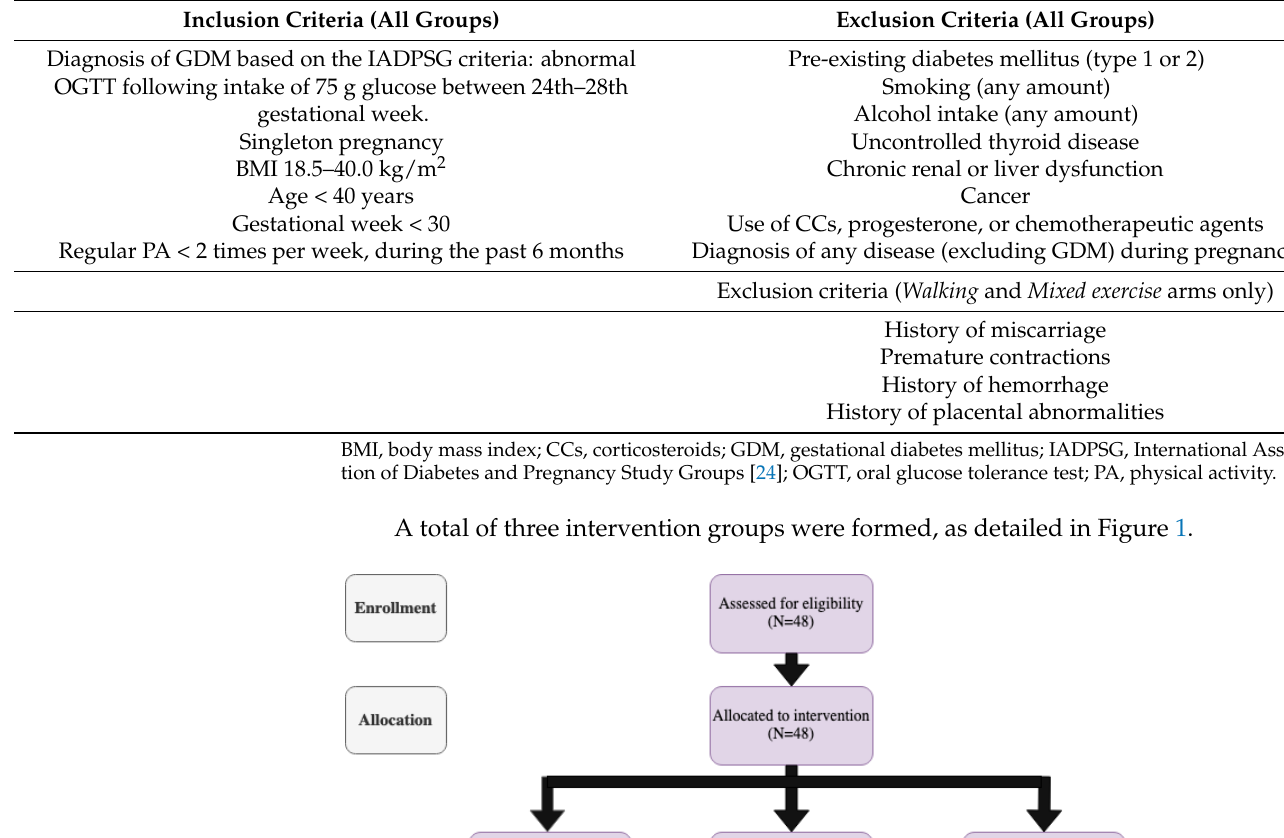
Table 1. Exclusion and exclusion criteria.